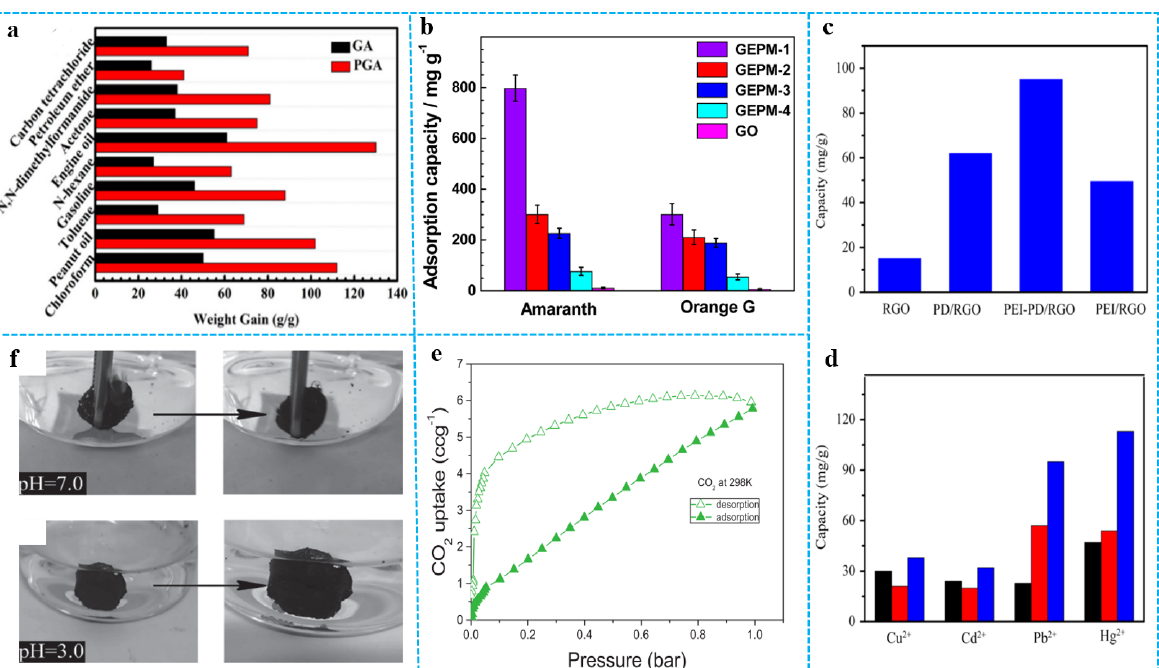
Figure 15. ( a ) Absorption capacities of GA and PGA for various oil and organic solvents. Reproduced with permission from [133]. ( b ) Adsorption capacities of GEPMs for amaranth and orange G by GO − PEI porous material (GEPM) and GO. Reproduced with permission from [134]. ( c ) Adsorption capacity of Pb 2+ on RGO, PD/RGO, PEI-PD/RGO, and PEI/RGO aerogels. ( d ) Comparison of adsorption capacity of Cu 2+ , Cd 2+ , Pb 2+ , and Hg 2+ on active carbon (black), PEI/RGO (red), PE1- PD/RGO (blue) aerogels. Reproduced with permission from [135]. ( e ) CO 2 adsorption and desorption of chitosan-grafted GO aerogel at 298 K. Reproduced with permission from [136]. ( f ) The adsorption of chloroform by the ss -GF in water of pH 7.0 and the desorption of chloroform by the ss -GF in water of pH 3.0. Reproduced with permission from [137].